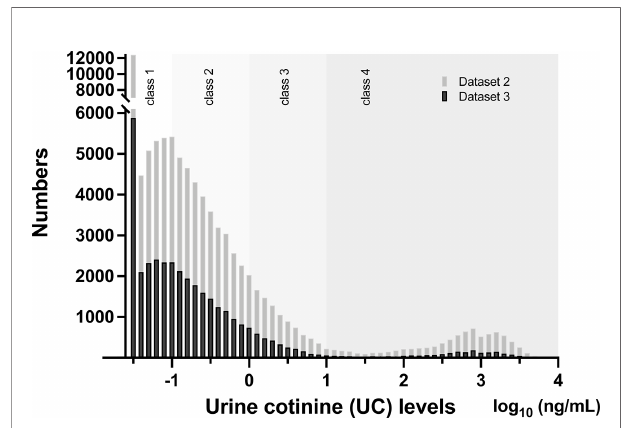
FIGURE 1 | Distribution of urinary cotinine (UC) levels in Dataset 2 (n = 89617) and Dataset 3 (n = 35829) Bars represent numbers in individual UC concentration in log 10 (ng/mL) and are categorized by UC classes. Please see detail in the text and Supplement 1 .